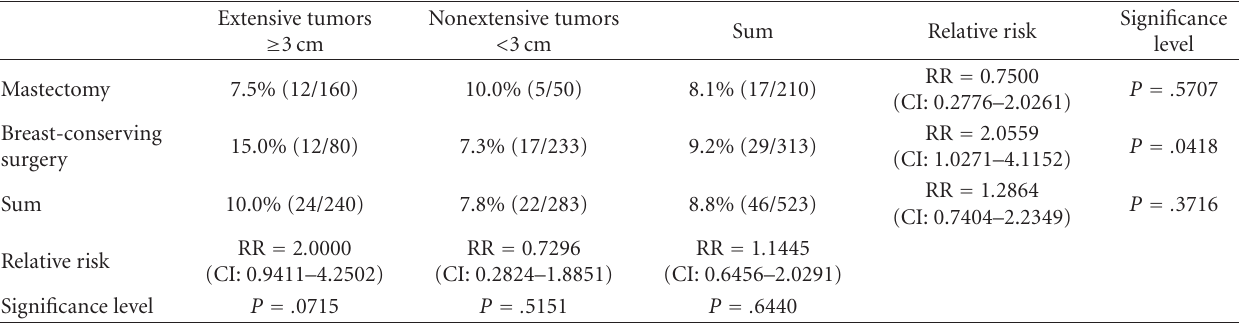
Table 2: Ipsilateral local recurrence rates by disease extent and type of surgery: extensive tumors defined as those occupying an area 3cm or larger in the greatest dimension. Falun 1996–1998, 10-year followup.